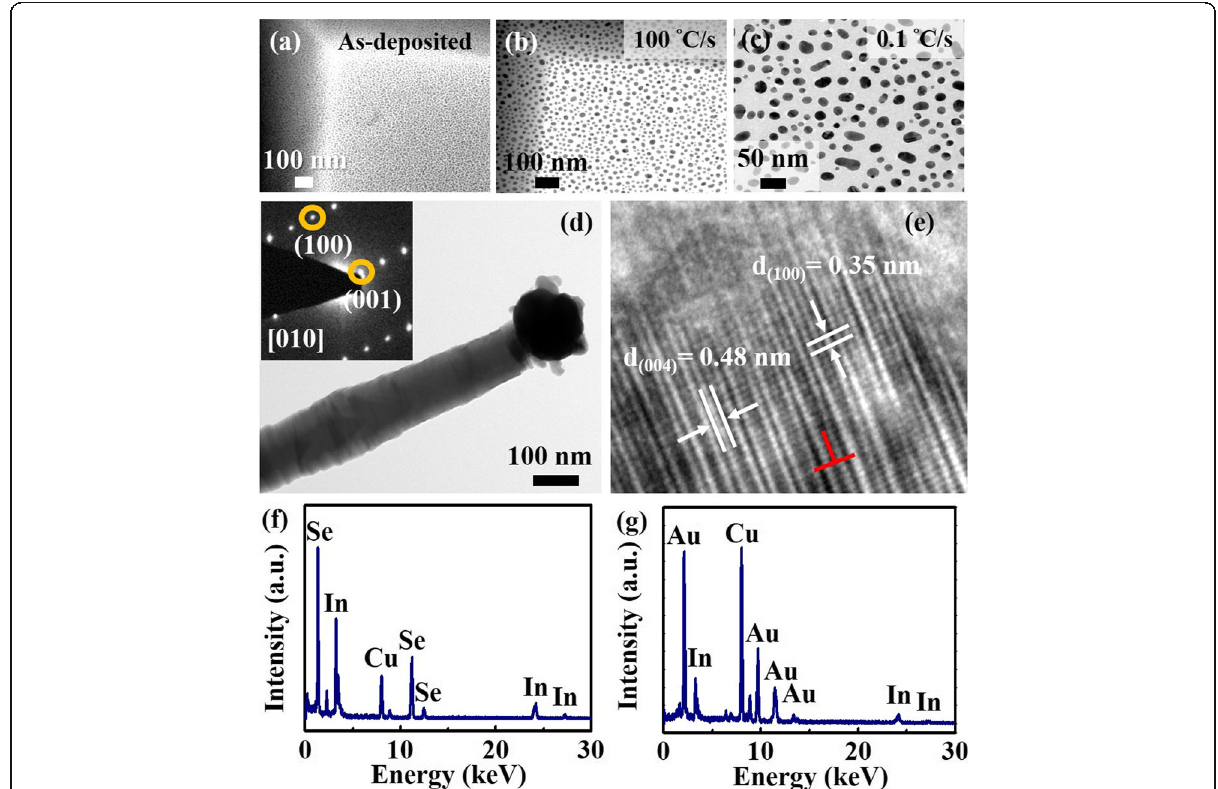
Fig. 3 a 2.0 nm Au film at room temperature. b The gold film by RTA at 550 °C in 100 °C/s. c The gold film was ramped up to the 550 °C in 0.1 °C/s. d TEM image of an as-synthesized individual α -In 2 Se 3 nanowire, with an Au nanoparticle tip. SAED pattern of the α -In 2 Se 3 nanowires (inset). e The corresponding HRTEM image of d shows the growth direction of the nanowire is along the [001]. f and g are the EDS spectra of the selected α -In 2 Se 3 nanowire taken from the body part and the tip part,